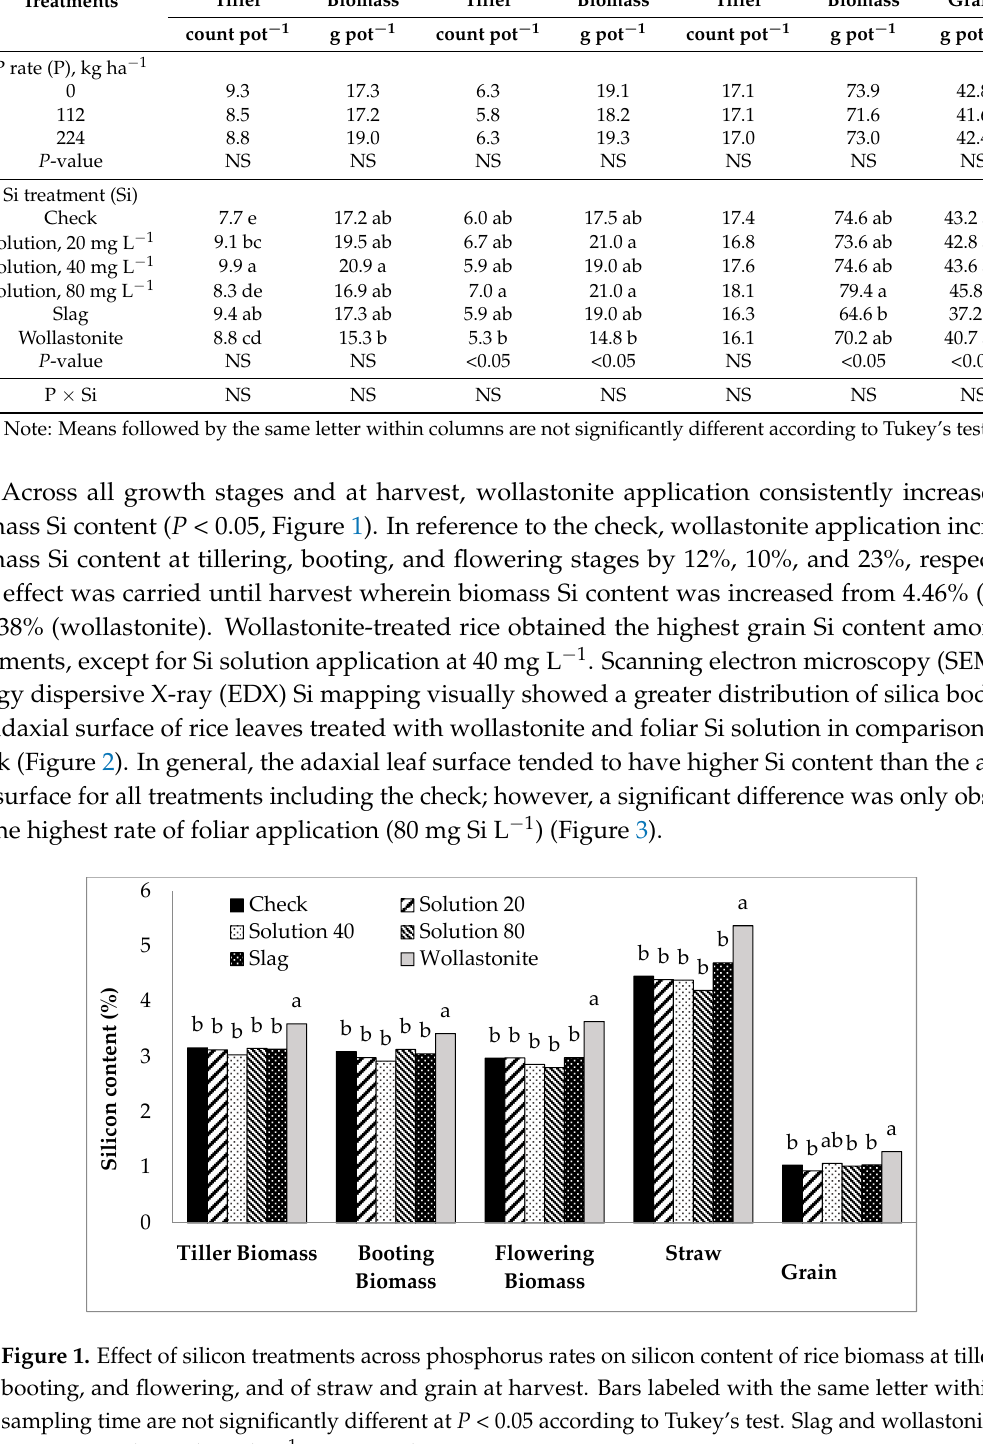
Table 1. Effect of phosphorus rate and silicon treatments on rice tiller count and biomass at booting, flowering, and harvest. Booting Flowering Harvest Tiller Biomass Tiller Biomass Tiller Biomass Grain Treatments